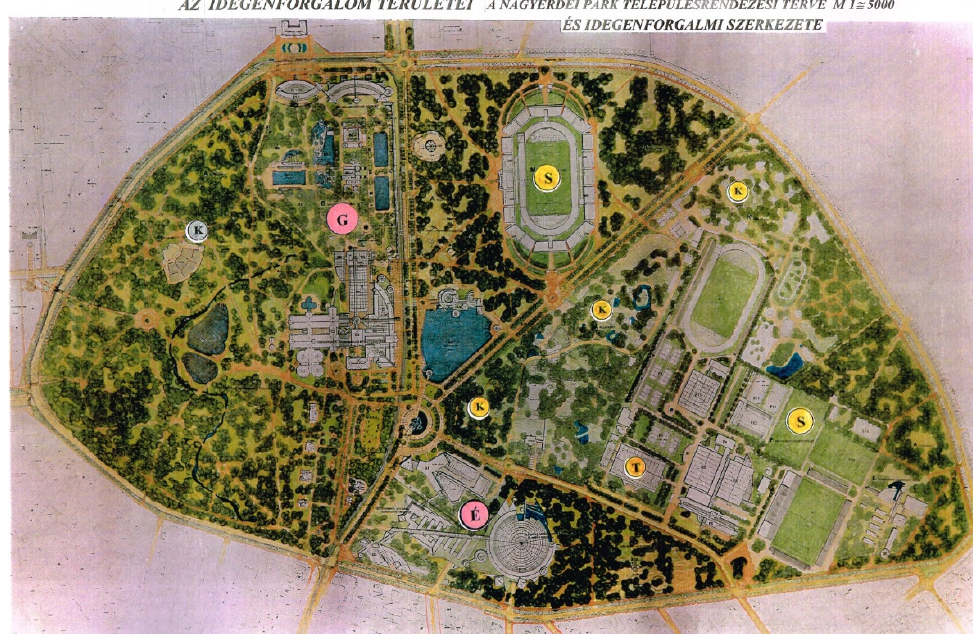
Figure 8. Development plan of Great Forest in 1996 (The meaning of numbers is found in the text.). Source: [35].